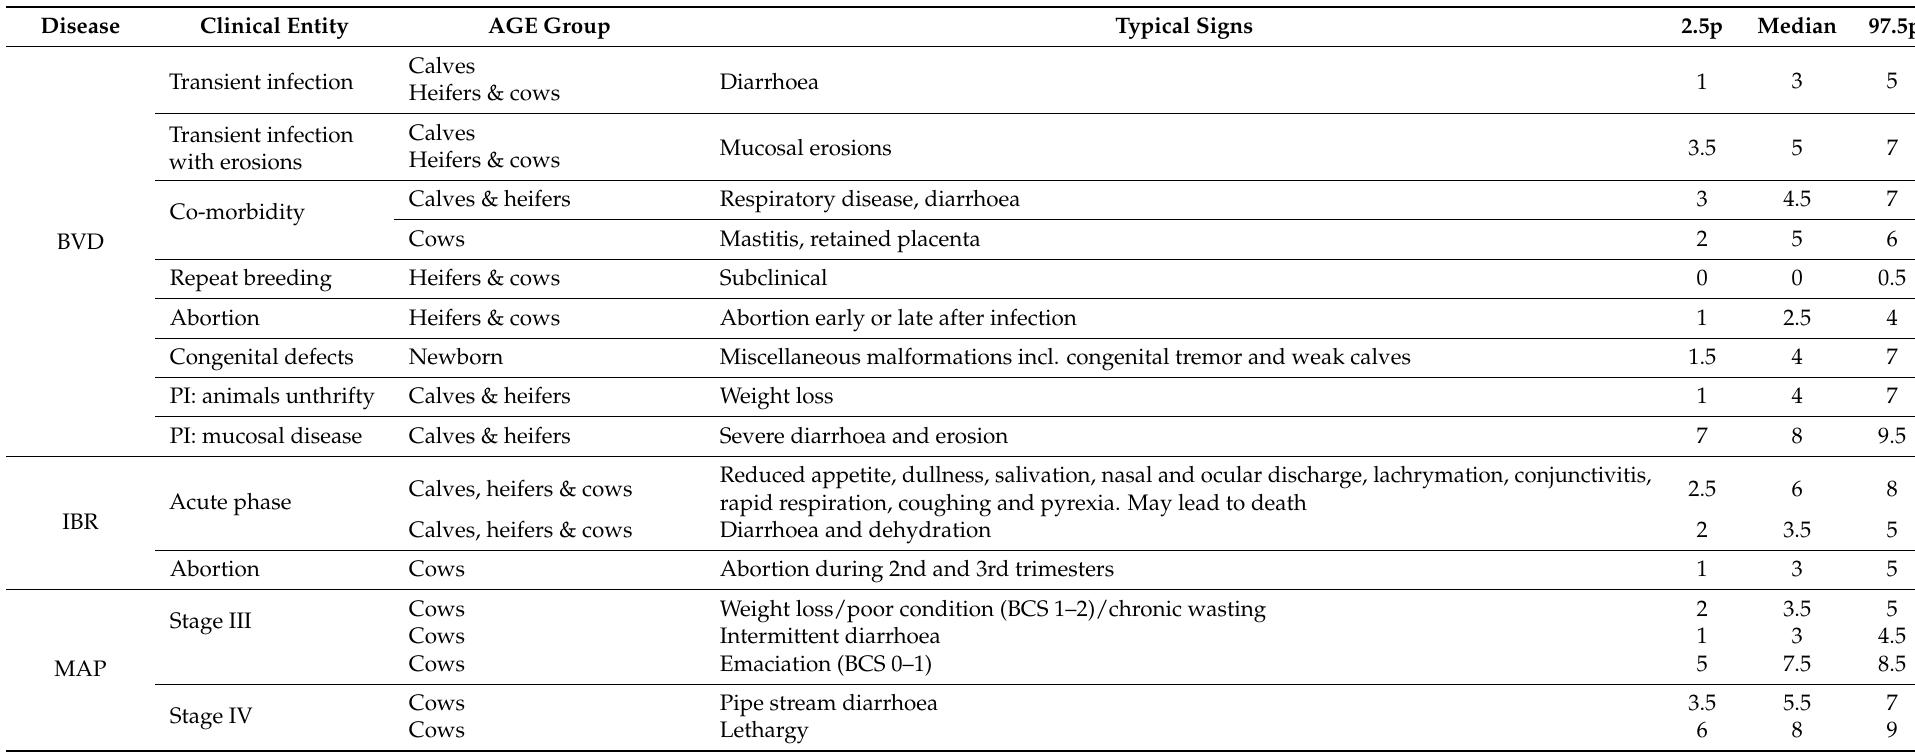
Table 5. Combined distributions of severity for clinical entities of five diseases 1 and ten non-infectious welfare hazards assessed through expert knowledge elicitation. The tabulated severity scores present the median of the scores from the eight experts for each of the percentiles 2.5, median, and